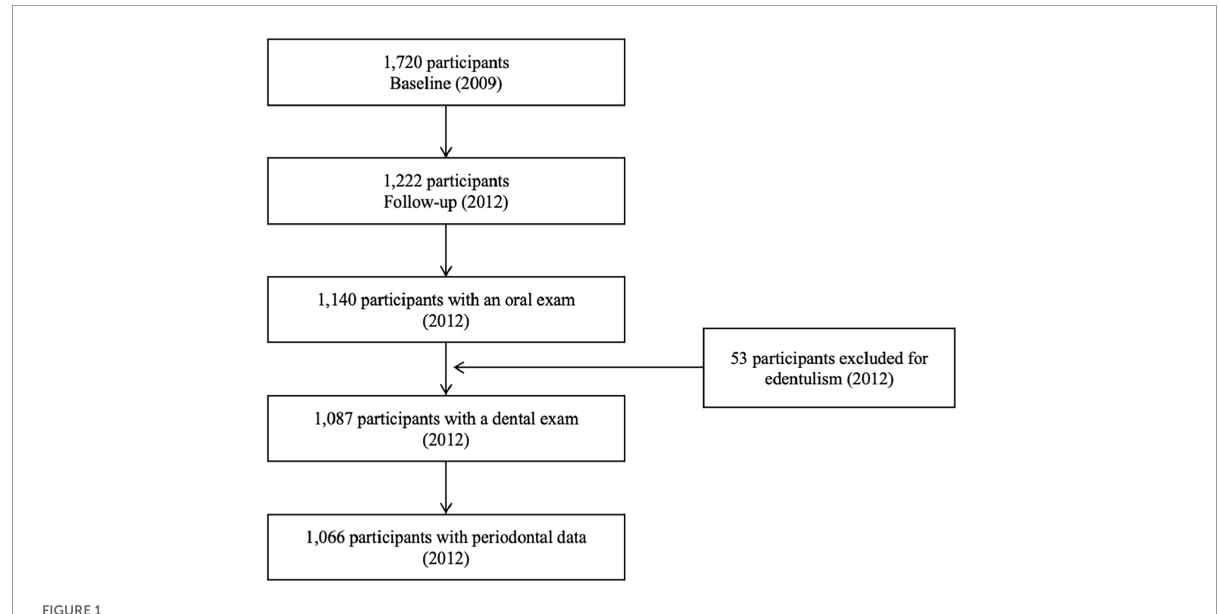
FIGURE1 Flowchart of the EpiFloripa cohort